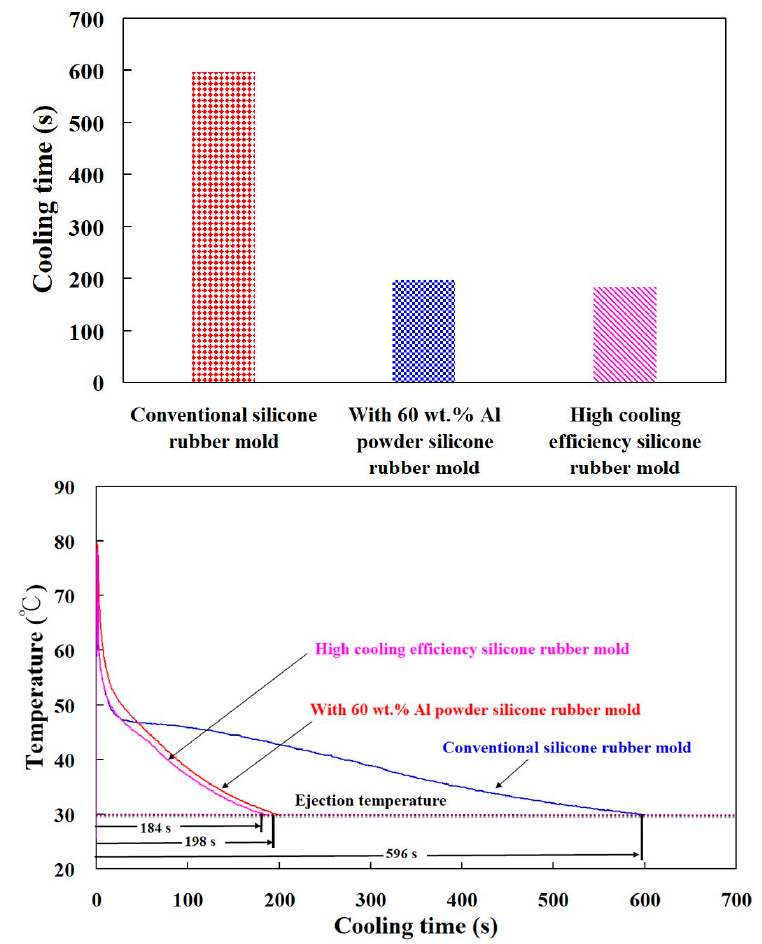
Figure 19. Temperature of the molded wax pattern as a function of actual cooling time.